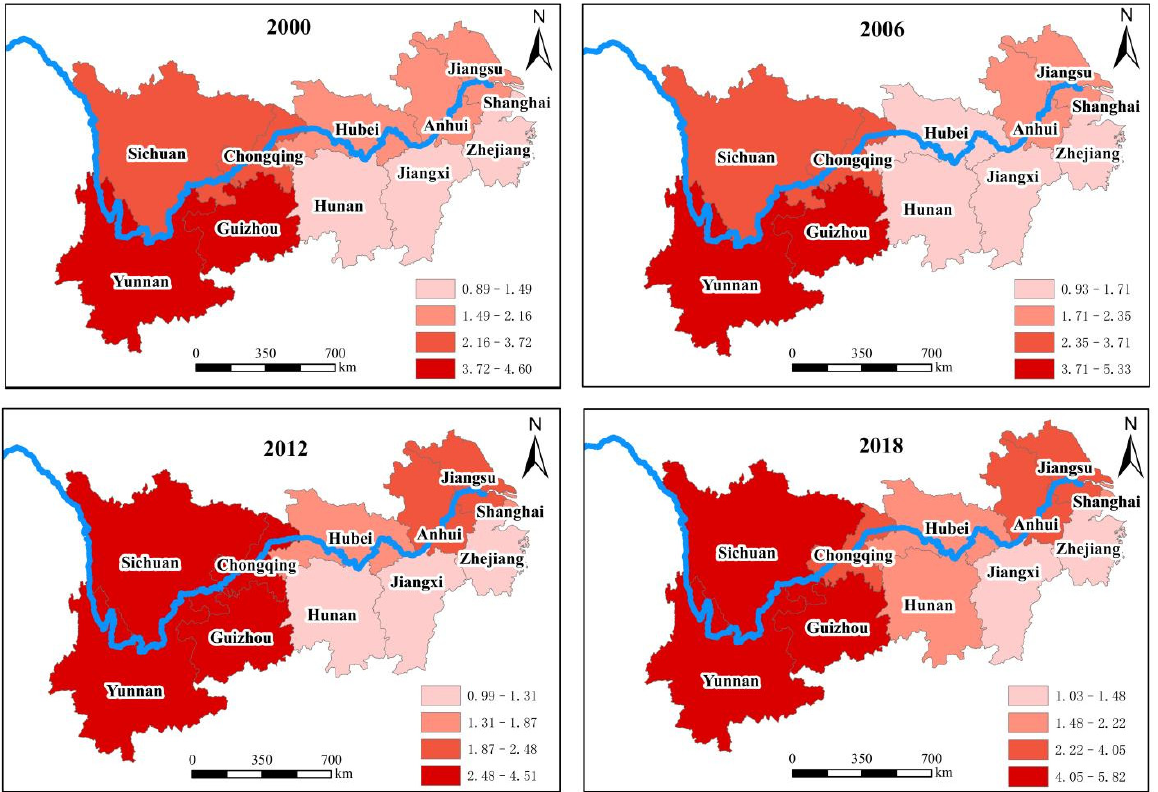
Figure 6. Changes of carbon sequestration level of food crops in 11 provinces (cities) of YREB. (Note: the level of carbon sequestrations is the ratio between carbon sequestrations and carbon emissions).